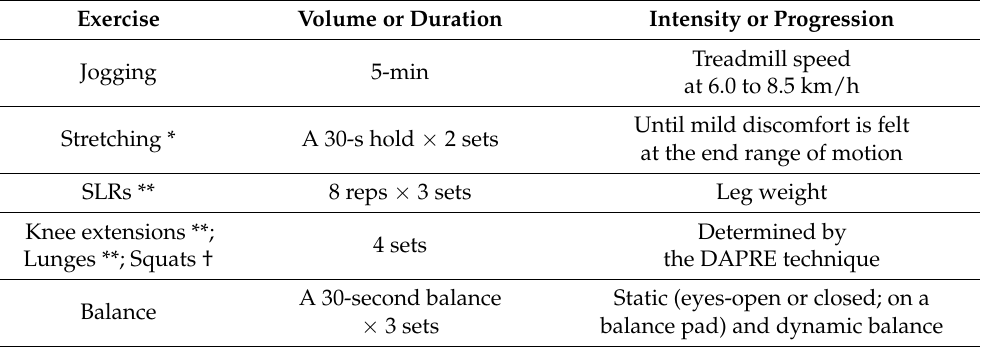
Figure 2. Electro-cryotherapy: electrode attachments were set for 2 channels of TENS ( A ) and 2 ice bags were secured by plastic wrap ( B ). Table 2. DAPRE technique-based exercise program.